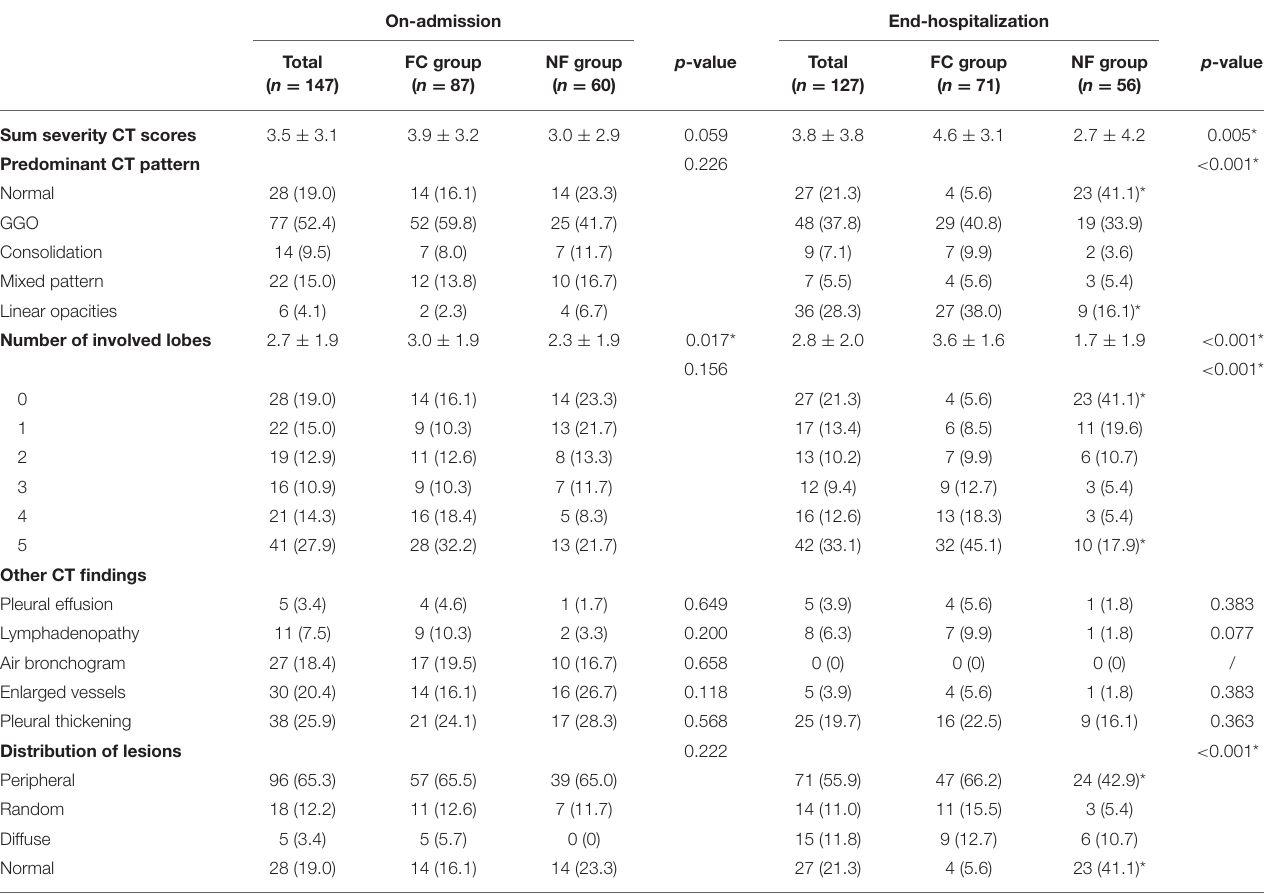
TABLE 3 | Comparison of CT features at different time points between FC and NF